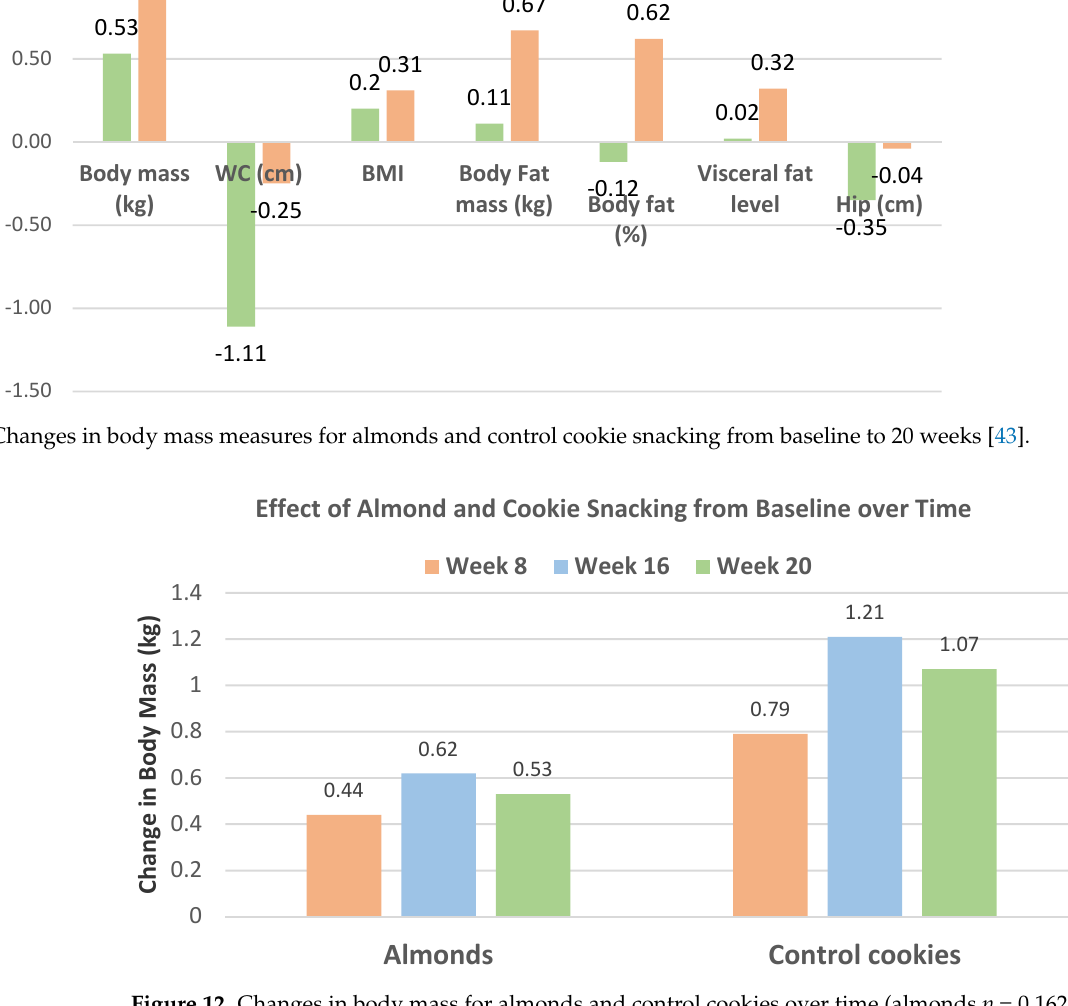
Figure 12. Changes in body mass for almonds and control cookies over time (almonds p = 0.162 and cookies p = 0.001) [43].